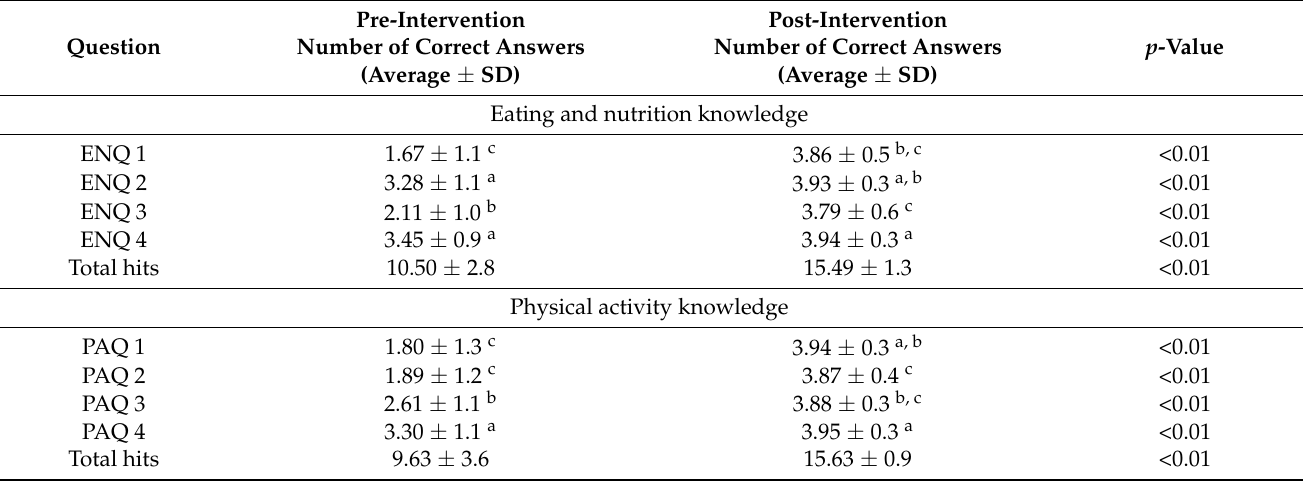
Table 4. Average of correct answers ( ± standard deviation) of questions about knowledge about eating, nutrition, and physical activity comparing pre-intervention and post-intervention